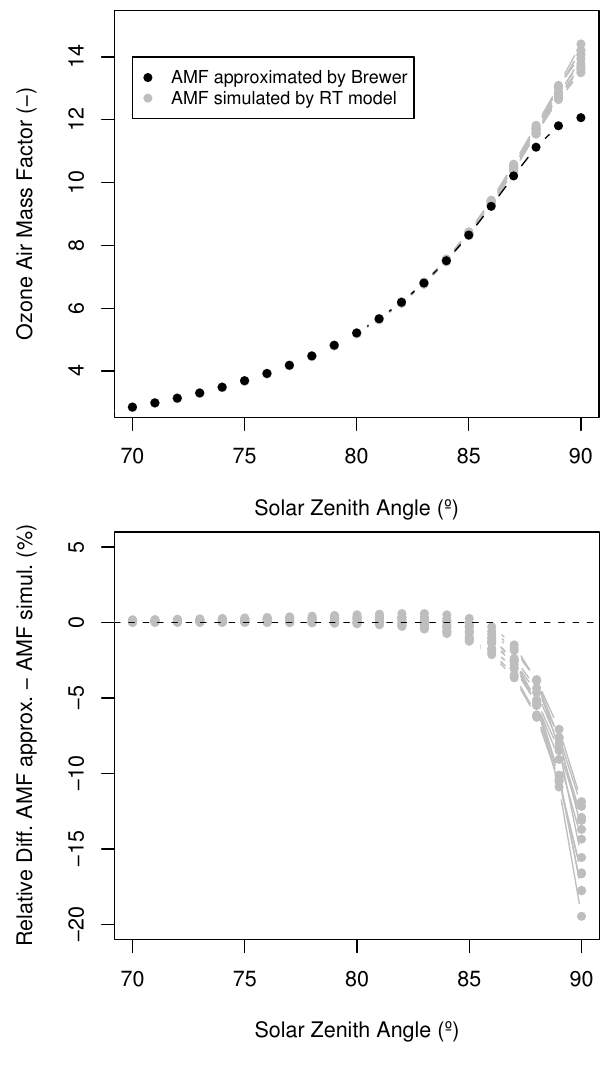
Fig. 1. Top: dependence of the ozone air mass factor (AMF) cal- culated by the Brewer algorithm (in black) and simulated with the libRadtran model for each month (in grey) with respect to the so- lar zenith angle. Bottom: relative differences between the approx- imated and simulated ozone AMF as a function of the solar zenith angle.